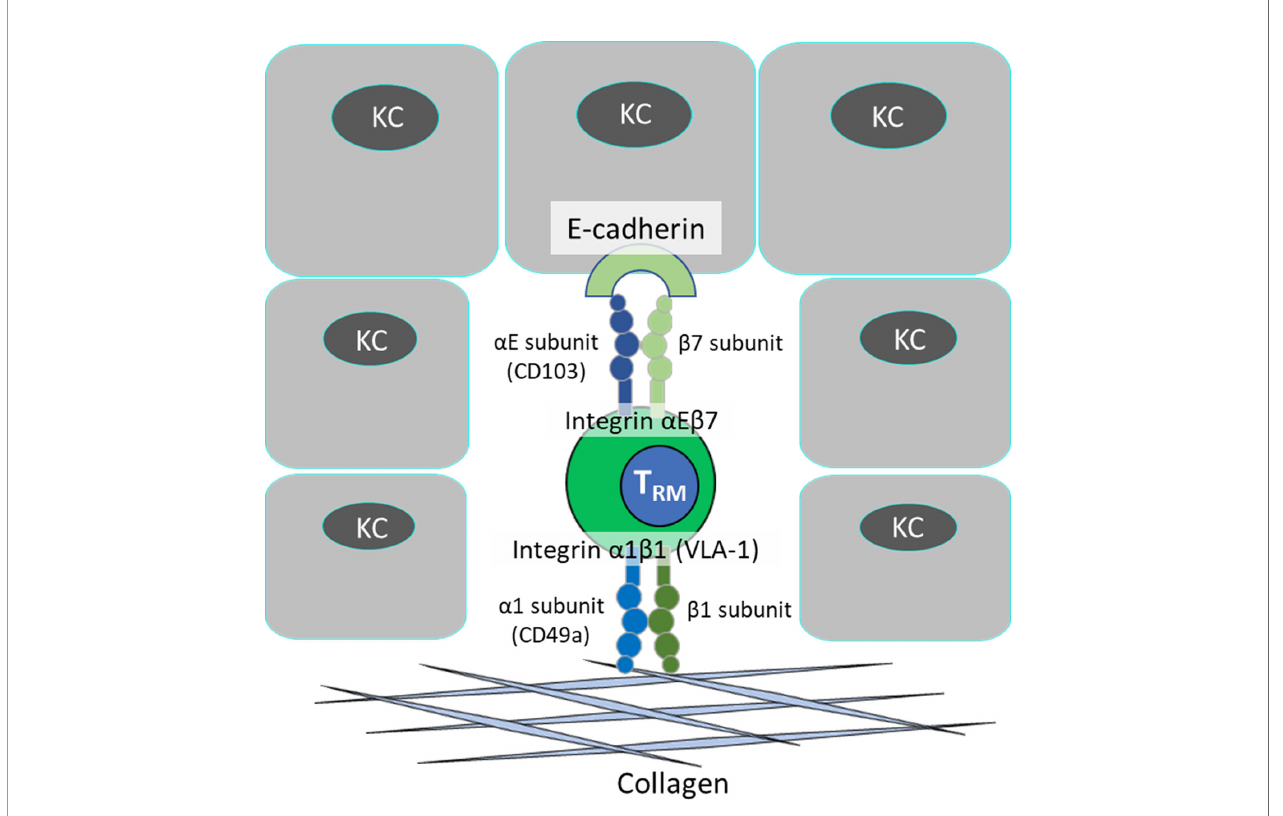
FIGURE 2 | Adhesion of T RM cell in the